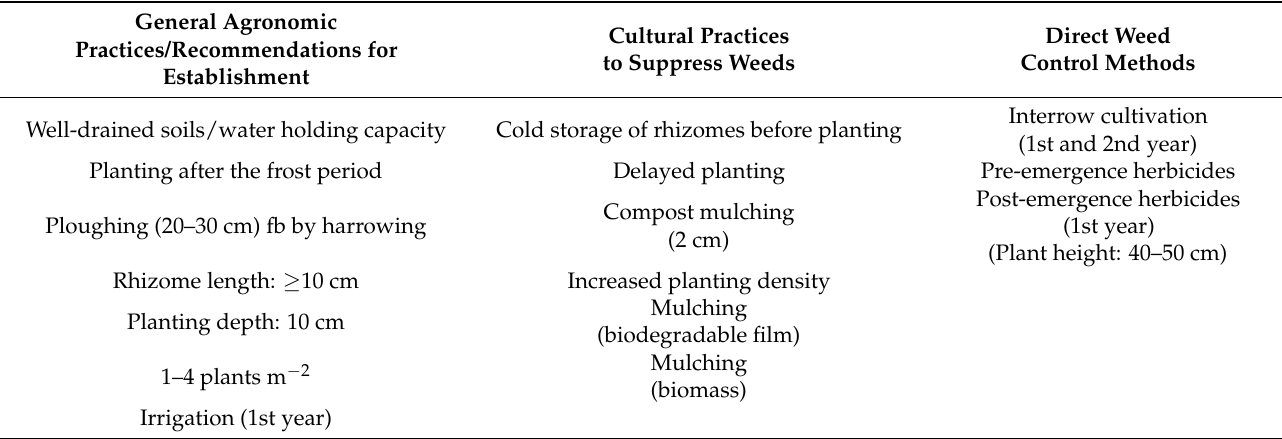
Table 1. General agronomic practices and recommendations for giant miscanthus establishment, cultural practices to suppress weeds and direct weed control methods. General